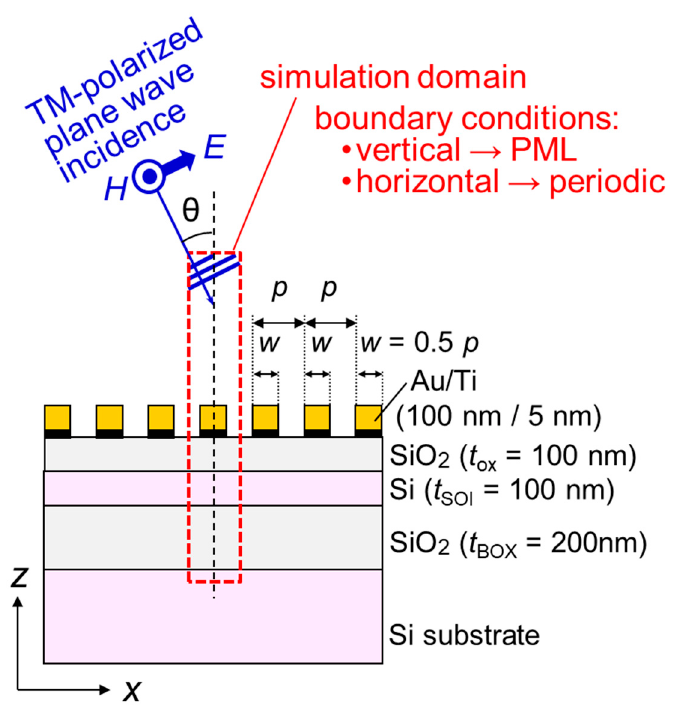
Figure 11. Simulated structure and conditions in finite-difference time-domain (FDTD) method for estimating quantum efficiency (QE) of SOI PD with SP antenna. PML represents perfectly matched layer, which is one of the absorbing boundary conditions used in FDTD method.